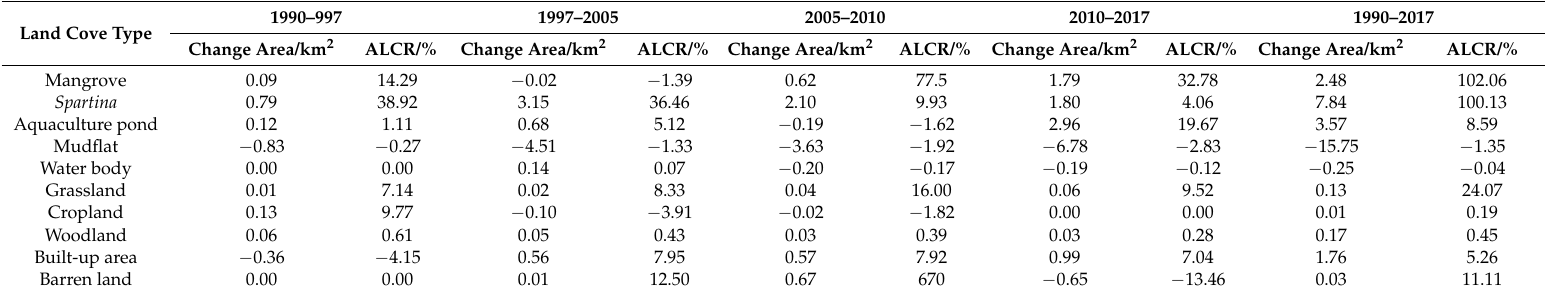
Table 4. Change area and annual land change rate (ALCR) of land cover types in study